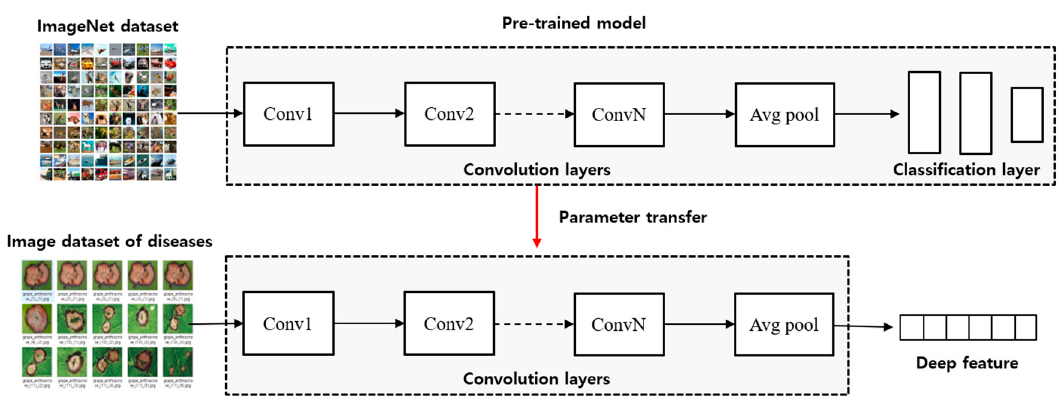
Figure 4. Structure of deep feature extractor.